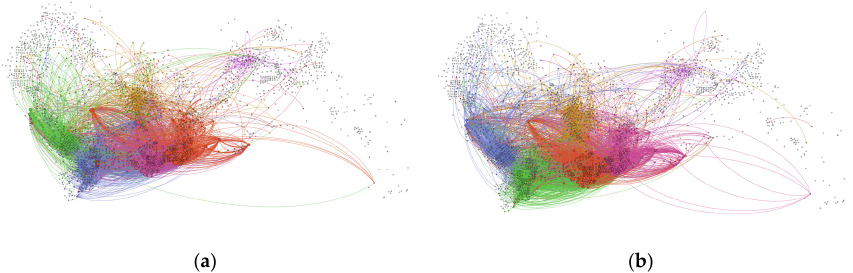
Figure 10. The directed network of taxi flow in peak periods of weekends: ( a ) Network in morning peak hours of weekends; ( b ) network in evening peak hours of weekends.